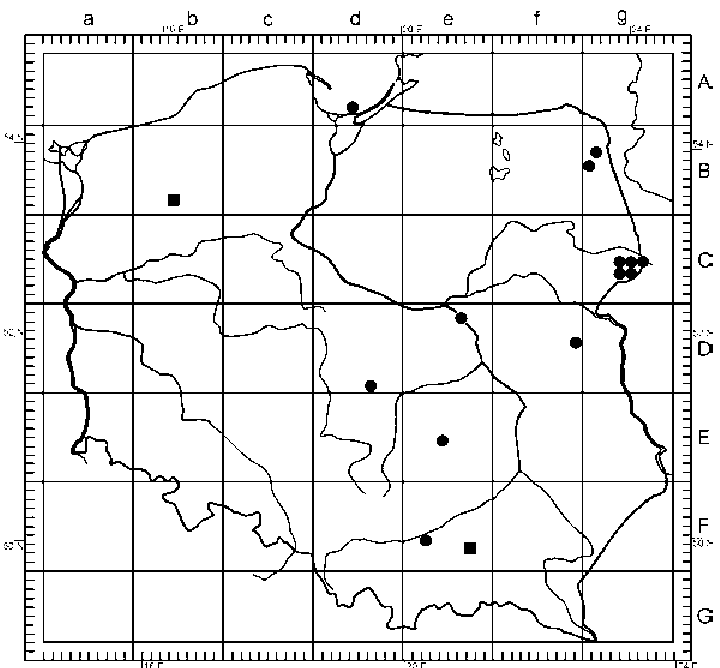
Fig. 3. Distribution of Xylobolus frustulatus (Pers.: Fr.) P. Karst. in Poland, in the ATPOL grid square system (Wojewoda 2000b): ■ – new localities, ● – known